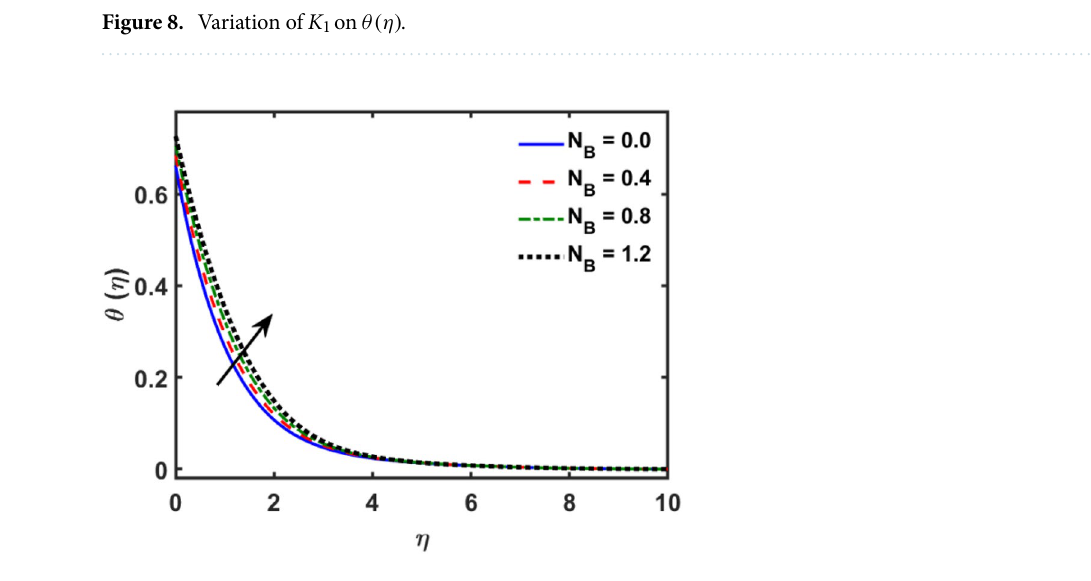
Figure 9. Variation of N B on θ(η)